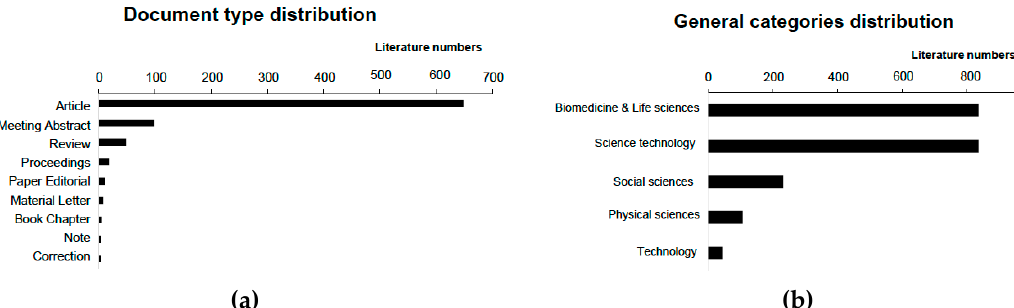
Figure 1. Annual distribution of publications on all telomere length research and telomere length in children research.